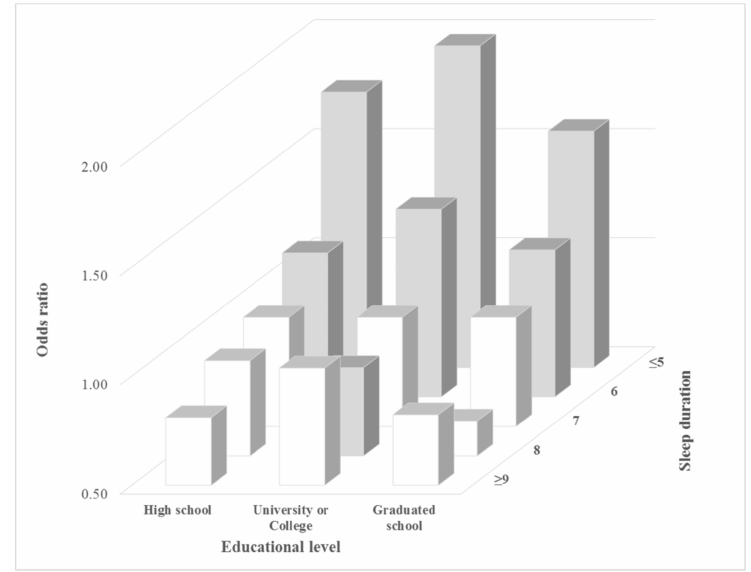
Figure 3. Subgroup analysis results for high-stress awareness according to educational level and sleep duration. Gray bar shows that the results of the multiple logistic regression were statistically significant ( p -value < 0.05). Analyses were adjusted for the following covariates: age, educational level, household income, occupational categories, marital status, physical activity, alcohol consumption, smoking status, BMI, perceived health status, depressed mood, and chronic